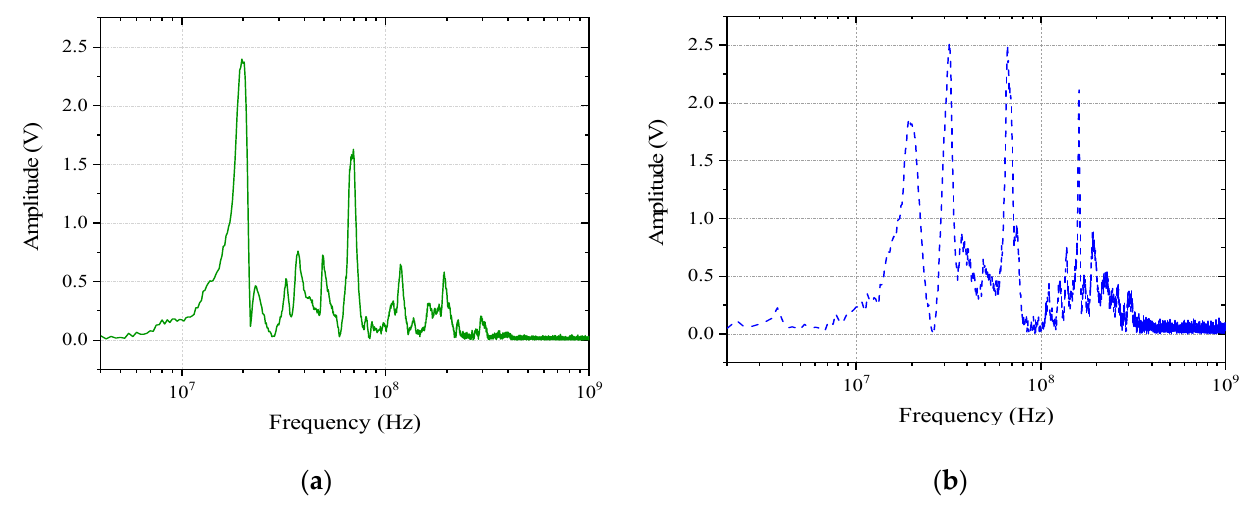
Figure 8. The frequency domain signal of the speed voltage : ( a ) Electric field strength is 10 kV/m; ( b ) Electric field strength is 20 kV/m. Table 2. Speed Sensor Coupling Voltage Signal.